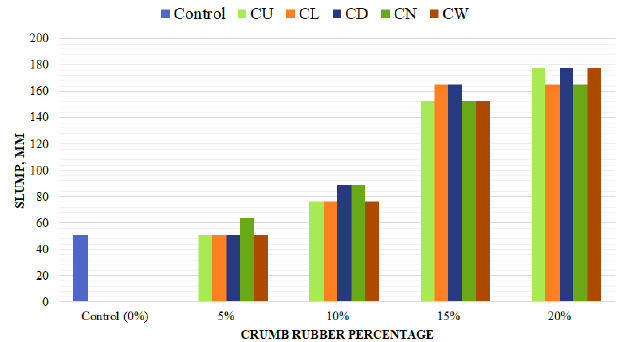
Figure 1. Slump test results.